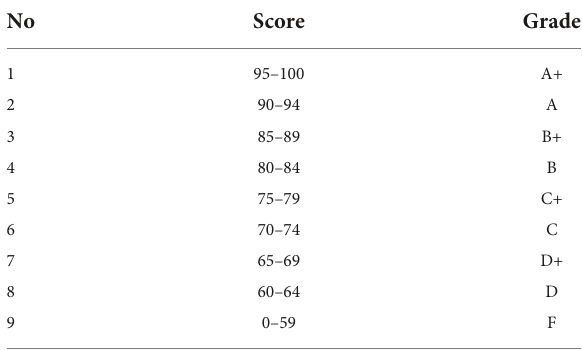
TABLE 2 Learners’ achievements (scores and